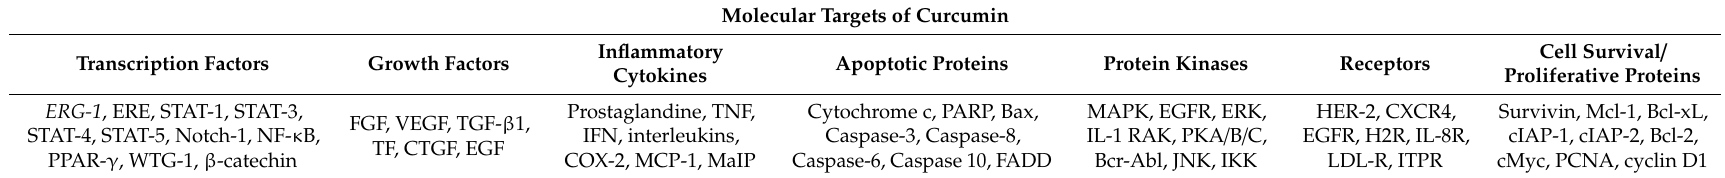
Table 1. Main molecular targets of